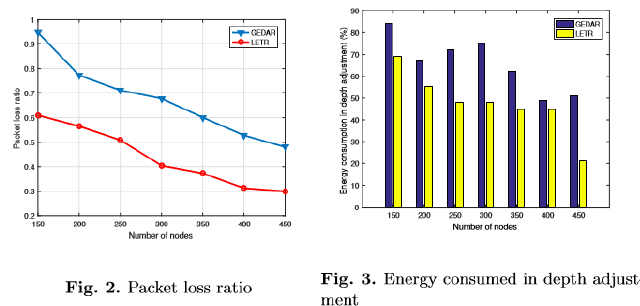
Fig. 4 plots the fraction of void nodes against total number of nodes deployed in the network field. As shown in the figure, number of void nodes decrease with increase in network density. LETR achieves best results due to transmission range adjustment and controlled depth adjustment of sensor nodes. In GEDAR, each void node moves downward in order to transmit its data either through its predecessor node or any other in range node. Such displacement of nodes disturbs whole network topology and increases the probability of void nodes in the network. On the other hand, when LETR is applied, the proposed transmission range adjustment along with depth adjustment mechanism reduces 85 percent the fraction of void holes at medium and high node